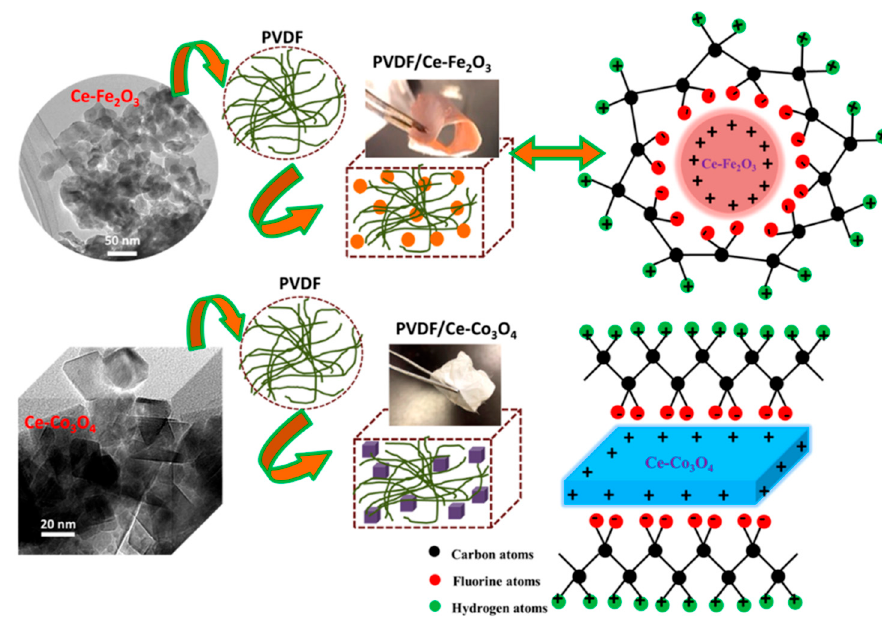
Figure 8. Schematic diagram of interaction between positively charged nanoparticles and dipoles in PVDF chains [63].